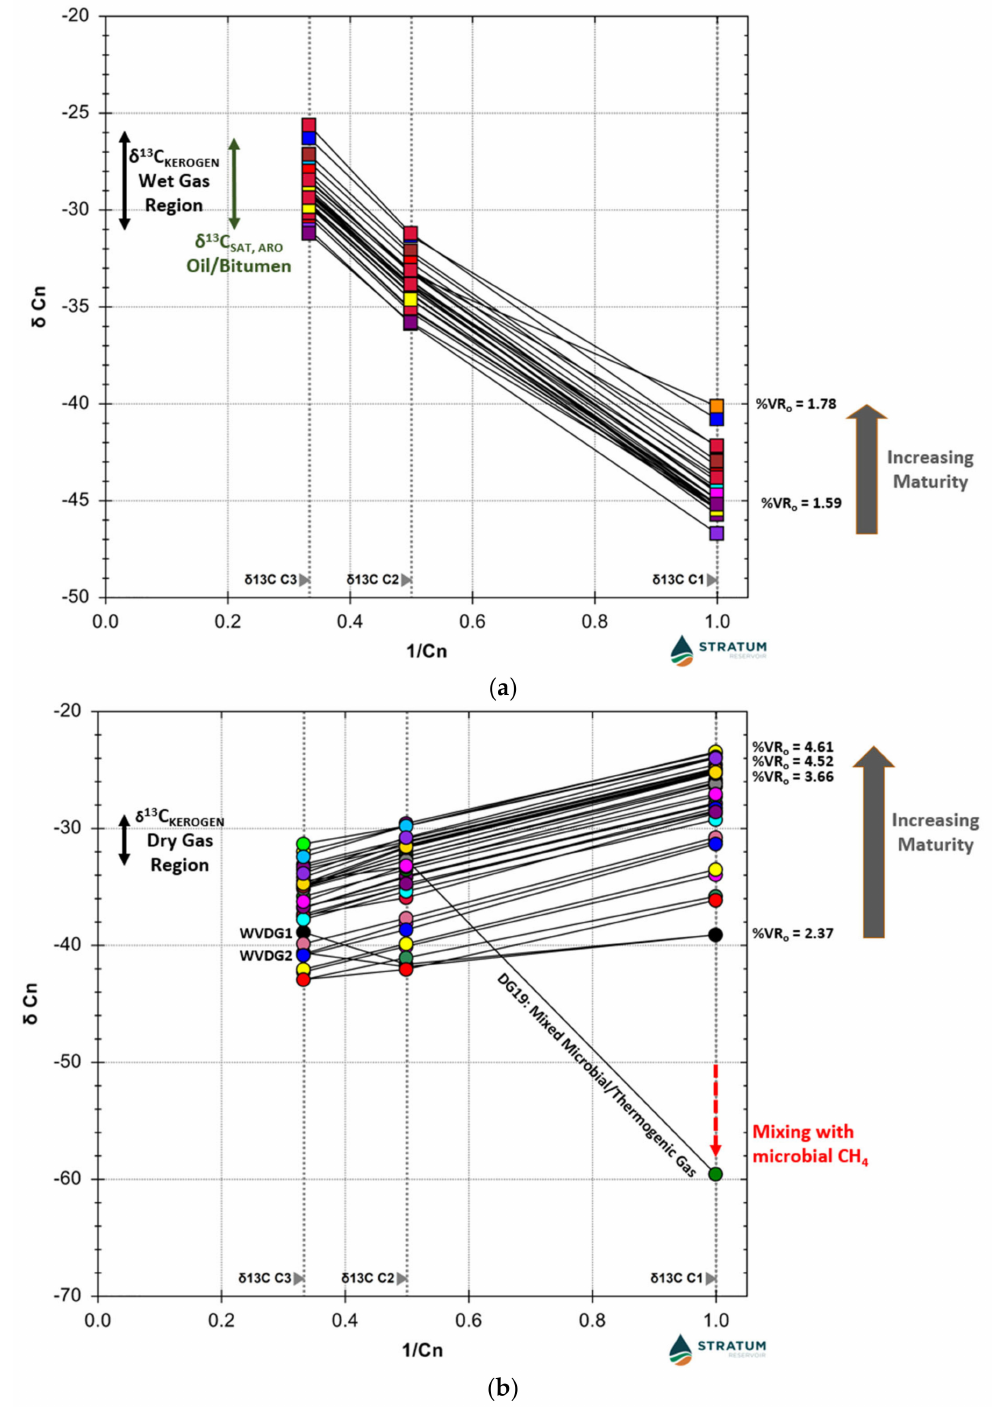
Figure 7. ( a ) : Natural gas plot for wet Marcellus Formation produced gases (after Chung et al. [39]). Kerogen and oil/bitumen δ 13 C range [12] is shifted right of the y -axis for clarity. ( b ) Natural gas plot for dry Marcellus Formation produced gases. VR o measurements by Dr. Wayne Knowles, Stratum